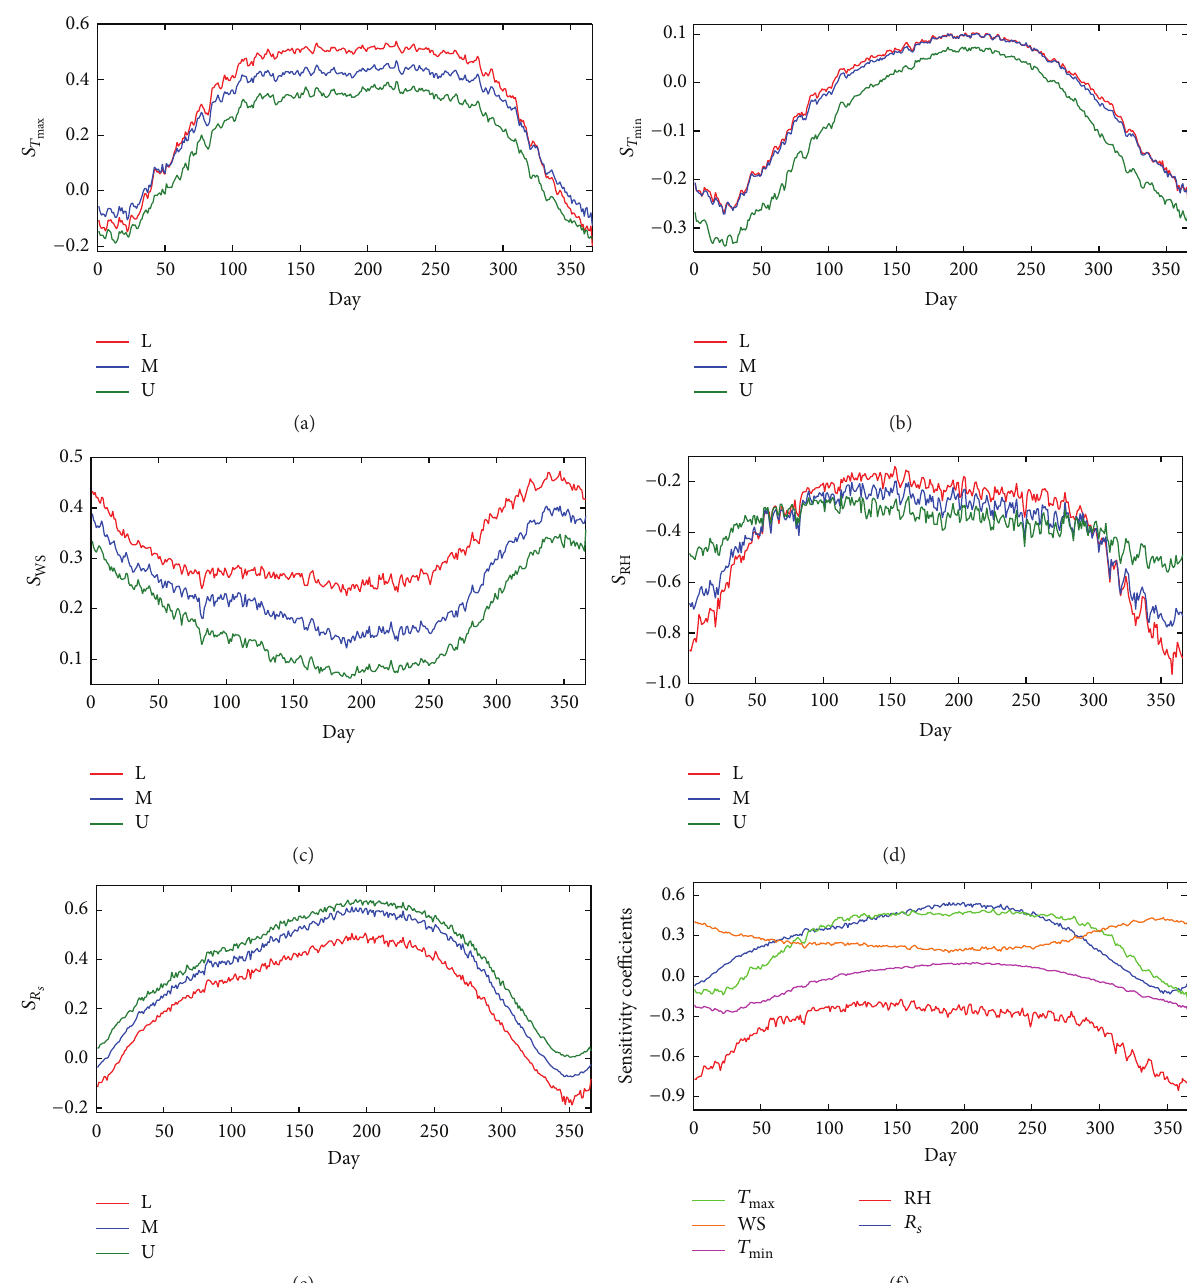
Figure 9: Mean daily sensitivity coefficients for maximum temperature (a), minimum temperature (b), wind speed (c), relative humidity (d), and shortwave radiation (e) in the upper (U), middle (M), and lower (L) regions of the HRB. (f) Comparison of the mean daily sensitivity coefficients for major meteorological factors in the whole